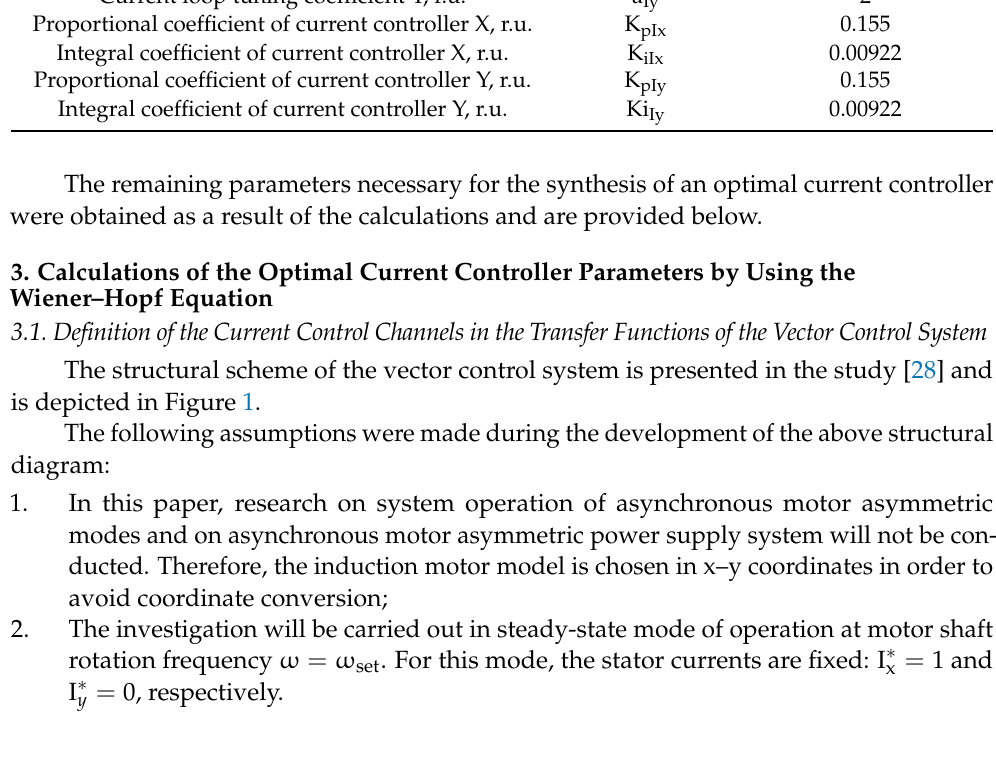
Table 2. Calculation results for the basic values and parameters of the controller. Parameter Designation Value Current loop tuning coefficient X, r.u. a Ix